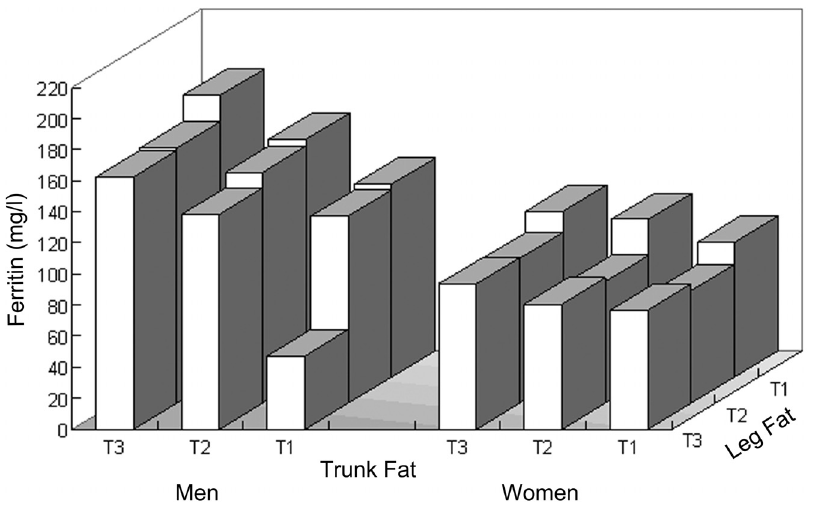
Figure 1. Adjusted mean levels of plasma ferritin according to the tertiles of trunk and leg fat mass. Data are geometric means for after adjusted for age, residence, alcohol drinking, smoking, educational attainment, physical activity, self-reported CVD, family history of diabetes and CVD and menopause status (in women participants). doi:10.1371/journal.pone.0013316.g001 PLoS ONE |